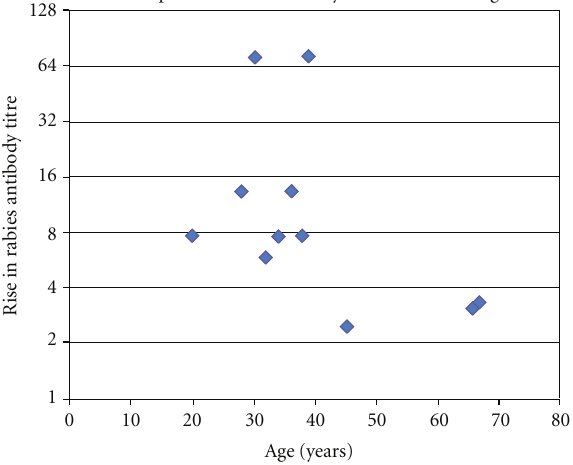
Figure 1: Scatter plot of antibody titre rise and age in years.